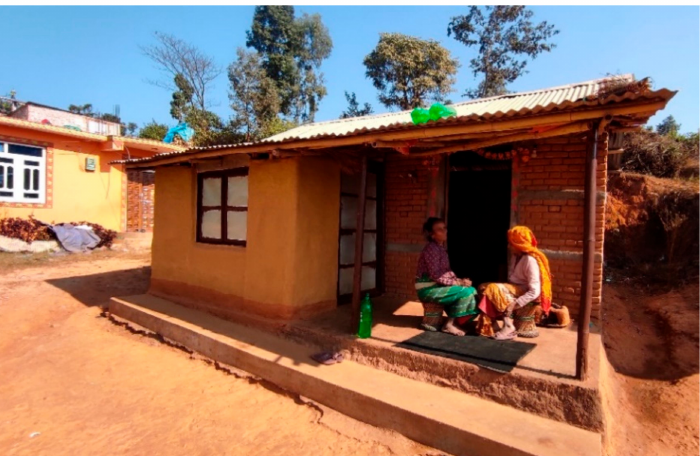
Figure 4. Houses built with Habitat for Humanity Nepal (HFHN) support allowed local designs with earthquake-resilient construction; note the horizontal ties in the walls (source: Sujit Maharjan, Habitat for Humanity,